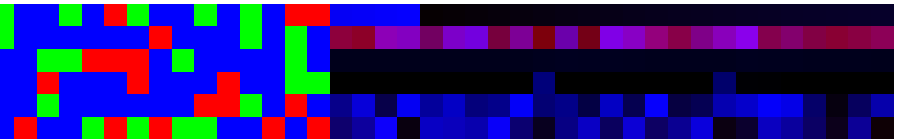
Figure 4. Example AIO for the union SNP set. The data on SNP and climate occupies the left and right sides of the image, respectively. The size of the image is 6 × 40 px. Here, the image is enlarged; each colored square corresponds to one pixel. The color of each pixel is obtained by (6) and (5) for genotypic and climatic factors, respectively.